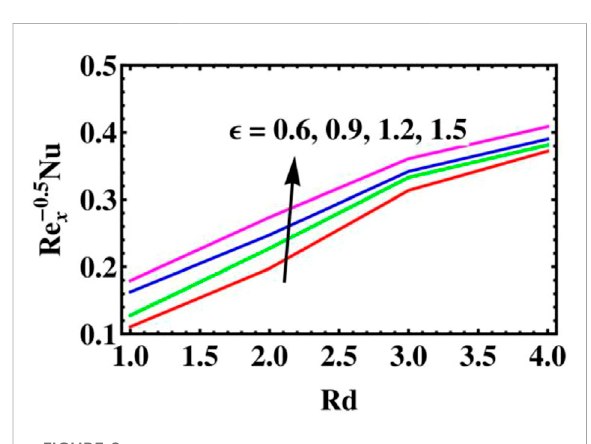
TABLE 2 Comparison of current fi ndings with earlier results for − θ 9 ( 0 ) under special